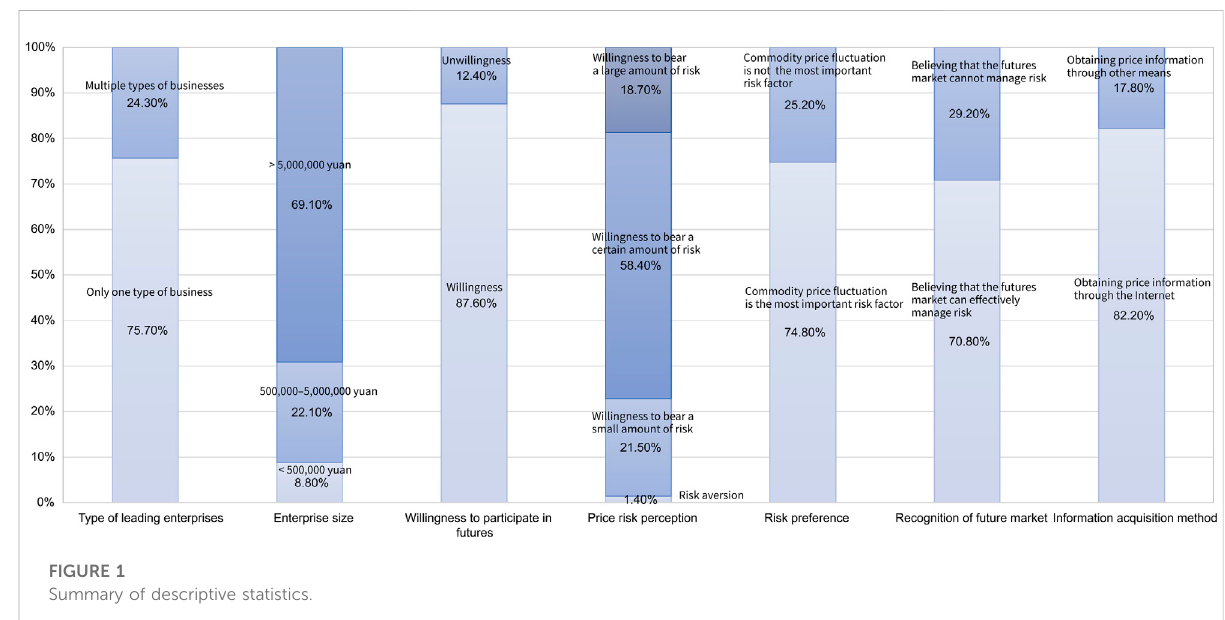
FIGURE 1 Summary of descriptive